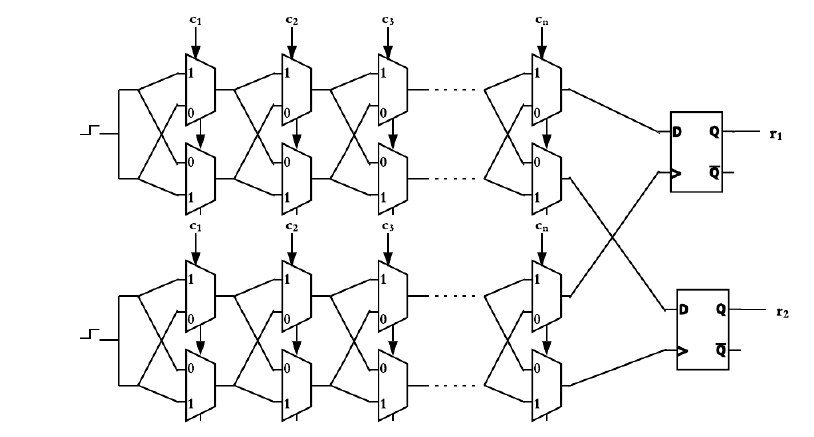
Figure 3. Structure of Double Arbiter PUF.